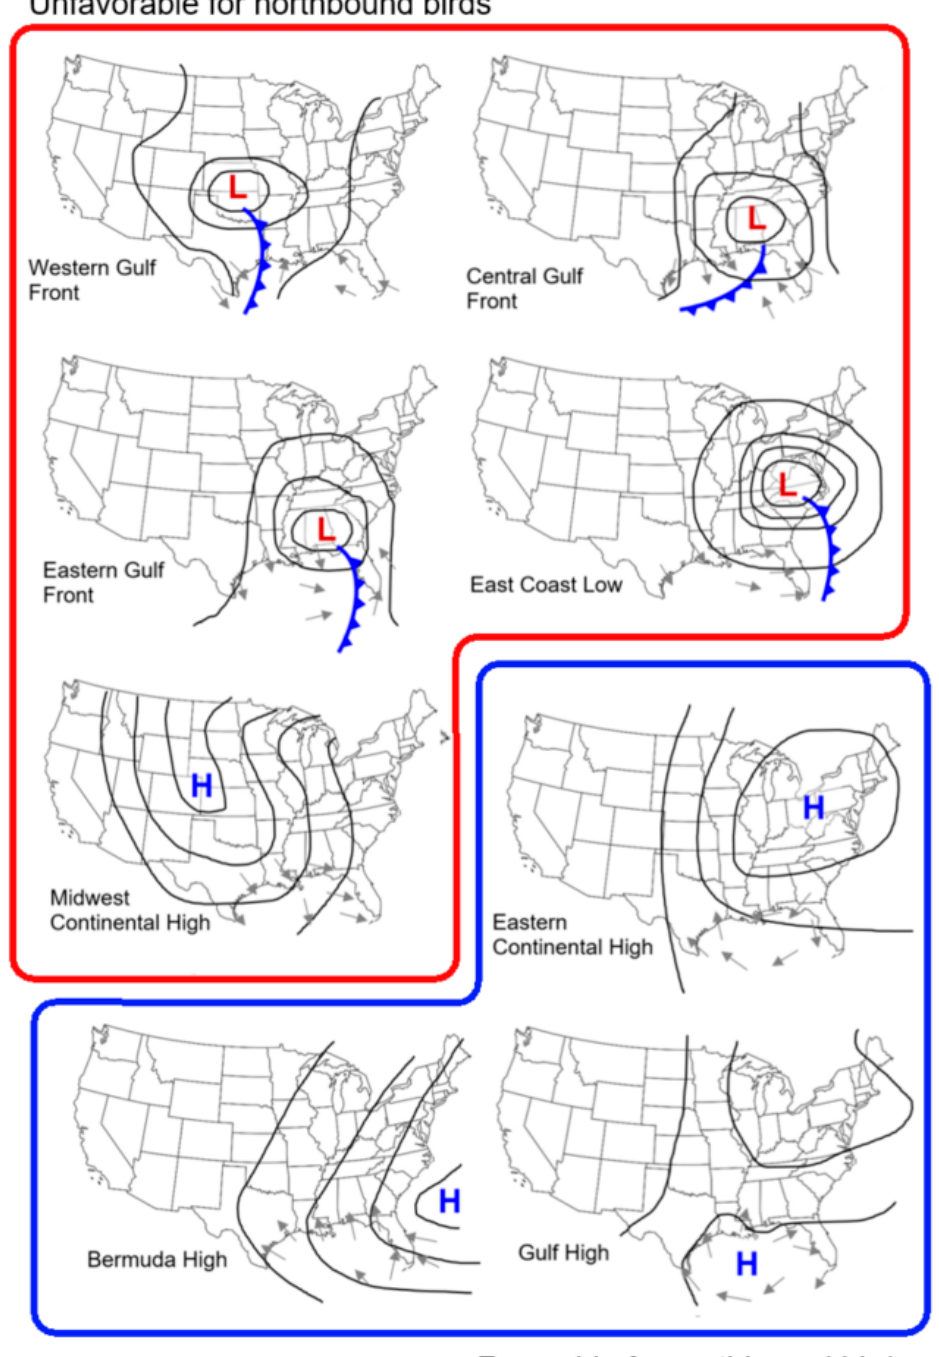
Figure 2. Generalized diagrams of the eight defined synoptic weather types considered in this study, with labeled pressure systems (“L” = low pressure, “H” = high pressure), pressure isobars (black lines), frontal system boundaries (blue lines with triangles denoting direction of movement), and general wind direction over the coast and Gulf of Mexico (indicated by the arrows). The first five synoptic weather types were considered unfavorable (Western Gulf Front, Central Gulf Front, Eastern Gulf Front, East Coast Low, and Midwest Continental High) and the last three favorable (Eastern Continental High, Bermuda High, and Gulf